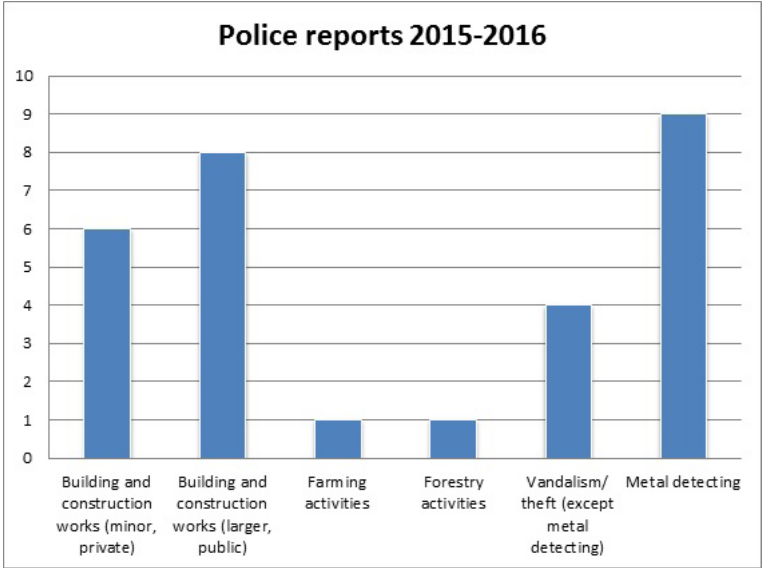
Figure 3. Cases of cultural heritage crime reported to the police in Norway during 2015 and 2016